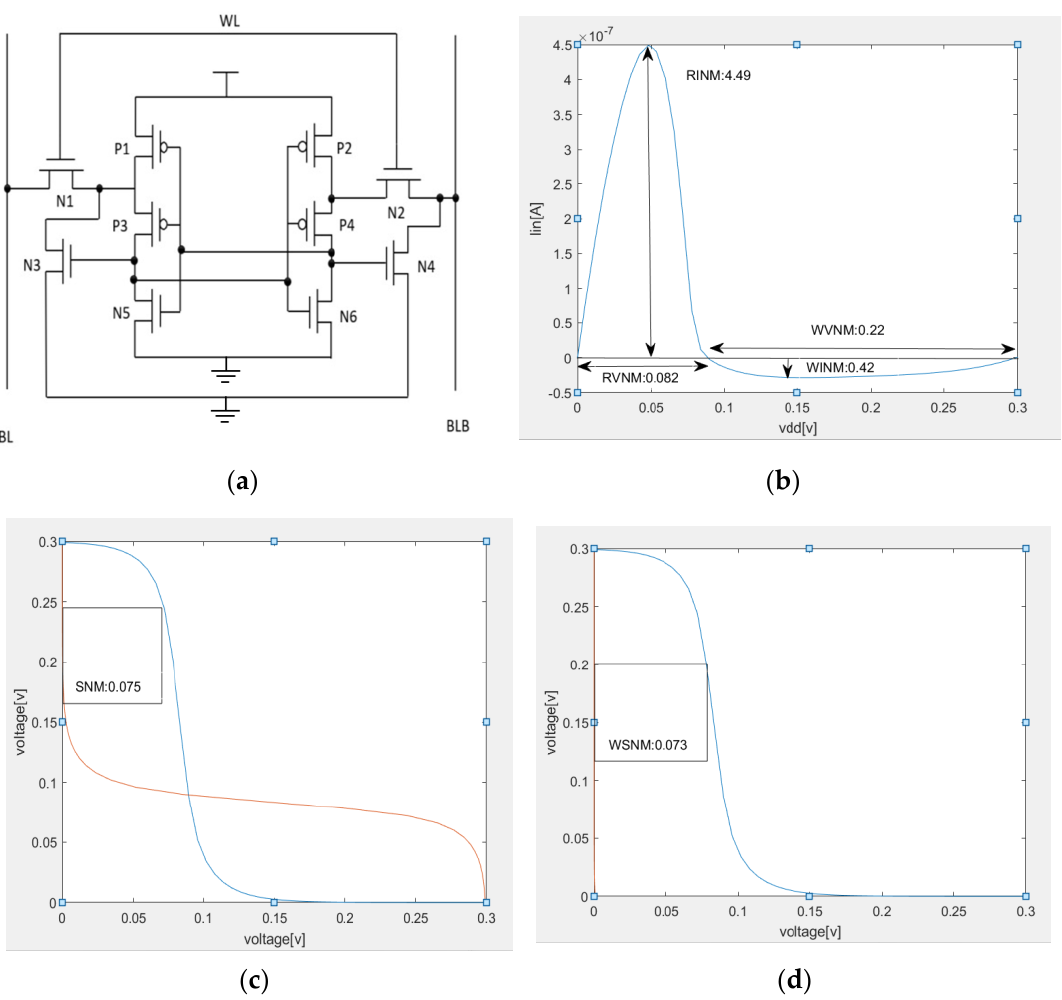
Figure 12. ( a ) 10T unit schematic; ( b ) stability based on leakage current; ( c ) read static stability; and ( d ) write static stability. Table 2. Simulation data